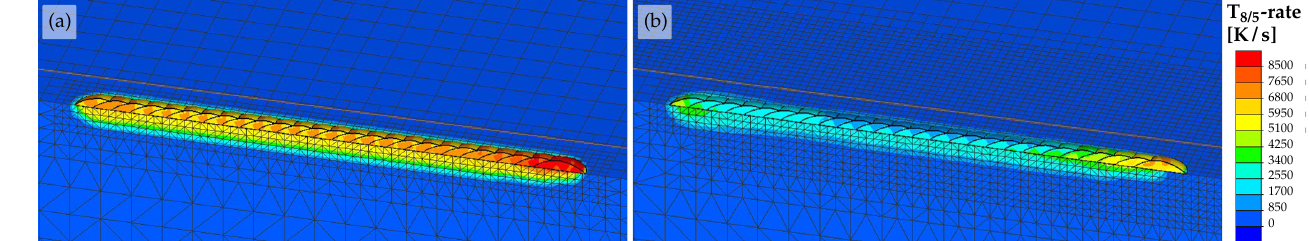
Figure 9. Sectional view along the welding seam of the simulated process with T 8/5 -rate: ( a ) Deposition welding without preheating. ( b ) Deposition welding with simultaneous inductive preheating.